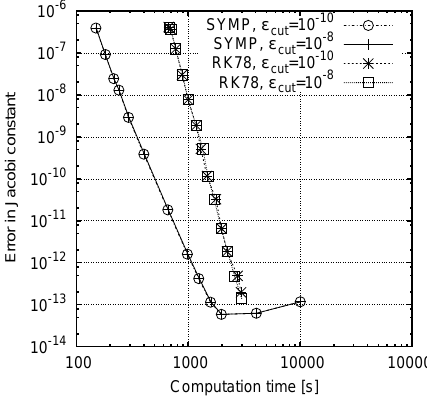
Fig. 15. The maximum errors in the Jacobi constant for SYMP and RK78 methods with ϵ cut = 10 (cid:0) 10 and ϵ cut = 10 (cid:0) 8